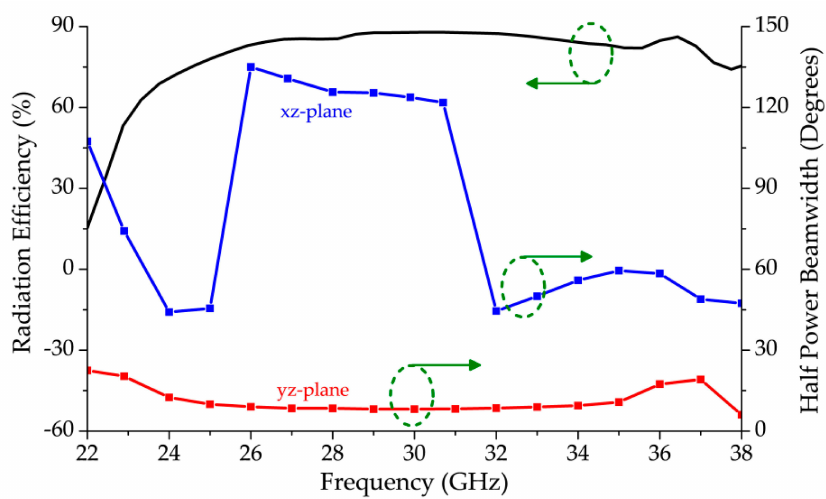
Figure 13. Radiation e ffi ciency and half power beamwidth (HPBW) plots of the proposed LWA.